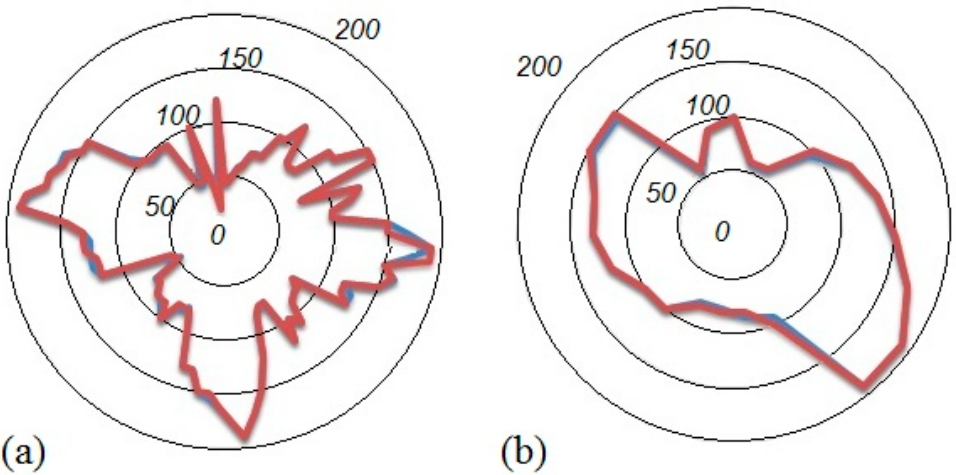
Figure 6. Overlap between the actual and predicted UCS results: ( a ) training set, ( b ) testing set.